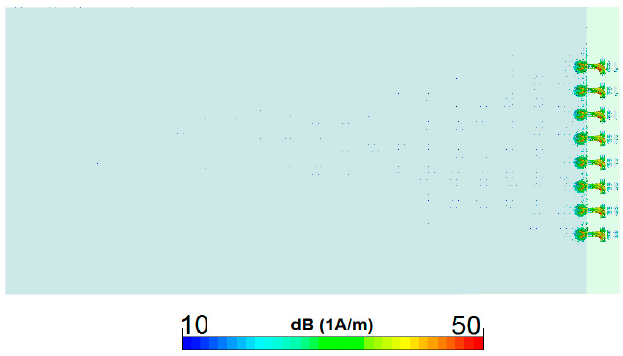
Figure 13. The current distribution at 26 GHz.